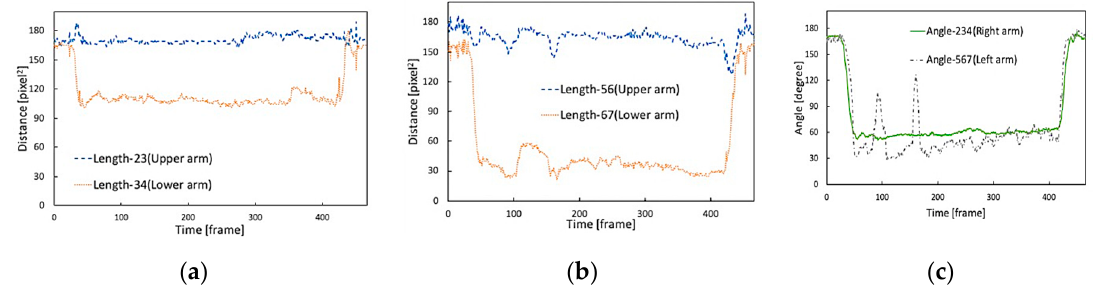
Figure 11. Arm’s length and angle of bending arms of subject 1 when performing net-surfing. ( a ) Right upper and right lower arm’s lengths; ( b ) left upper and left lower arm’s lengths; ( c ) angles of right bending and left bending arms.